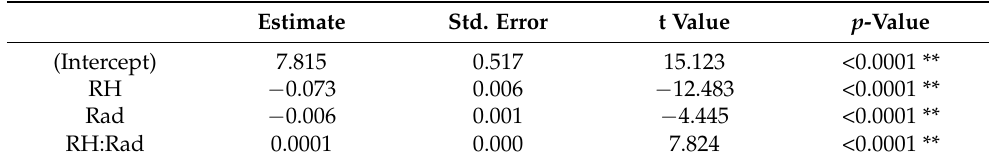
Table 1. Coefficients of a combined linear regression analysis in which the weather variables that had the strongest effect on conidia were used to predict conidia concentration according to the hour in the day. Abbreviations are as follows: RH (relative humidity); Rad (solar radiation); RH: Rad (interactions between relative humidity and solar radiation). Estimate Std. Error t Value p -Value (Intercept)